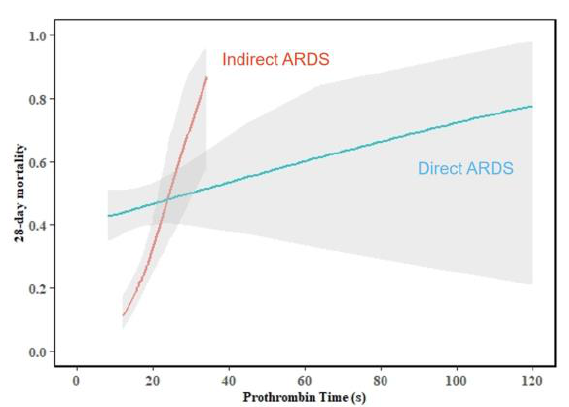
Figure 3. The interaction between prothrombin time and ARDS type (test for interaction, p < 0.001).